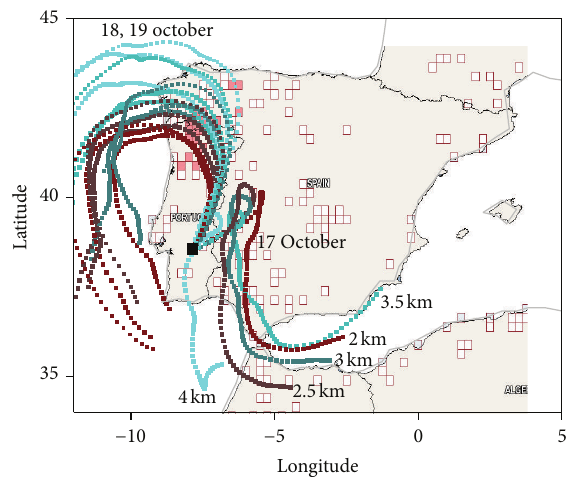
Figure 1: Fire hot spots detected by MODIS on board the Terra and Aqua satellites in the period from 15 to 18 October 2011 (http://firms.modaps.eosdis.nasa.gov/firemap/). 72-hour backward trajectoriesarrivingat ´Evora(blacksquare)atthelidarmeasurement times, between 17 and 19 October 2011, at 2, 2.5, 3, 3.5, and 4 km agl. For 18 and 19 October 2011 the colors are the same as for 17 October 2011.